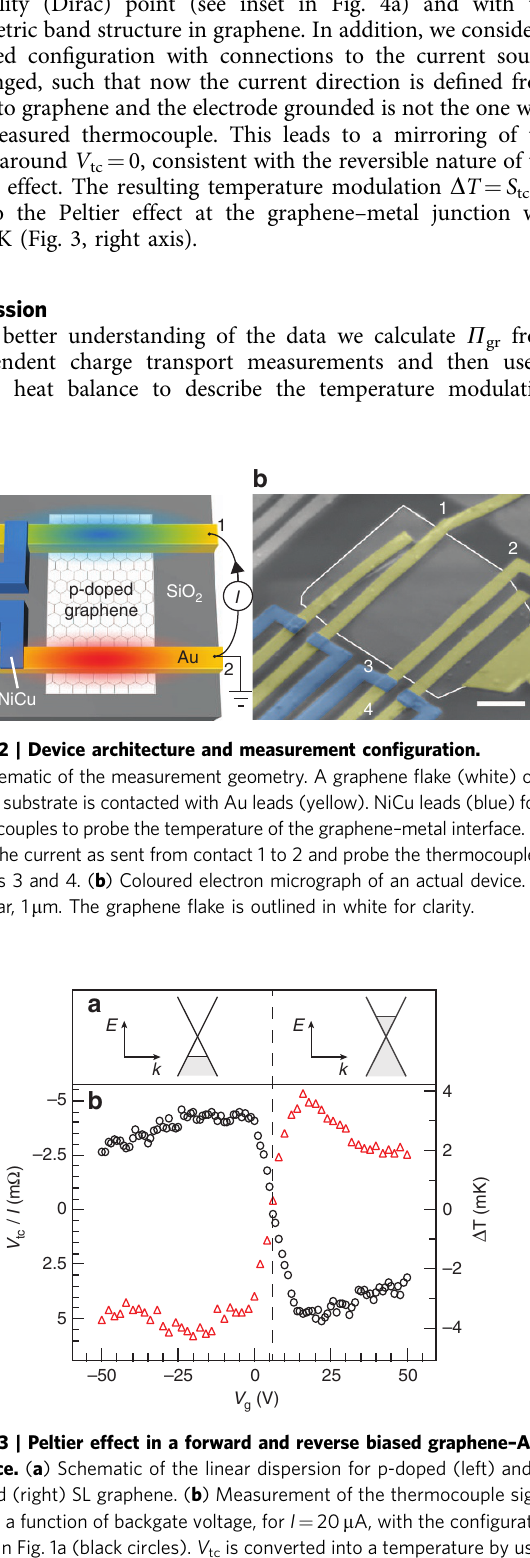
Figure 4 | Comparison of the Peltier effect in SL and BL graphene. ( a ) Comparison of Peltier measurement for SL graphene (black circles), with a calculation of the Peltier effect line shape (red lines) derived from charge transport (inset, black lines), using equations (1) and (2). ( b ) Similar comparison for BL graphene, with a calculation using equations (1) and (3).